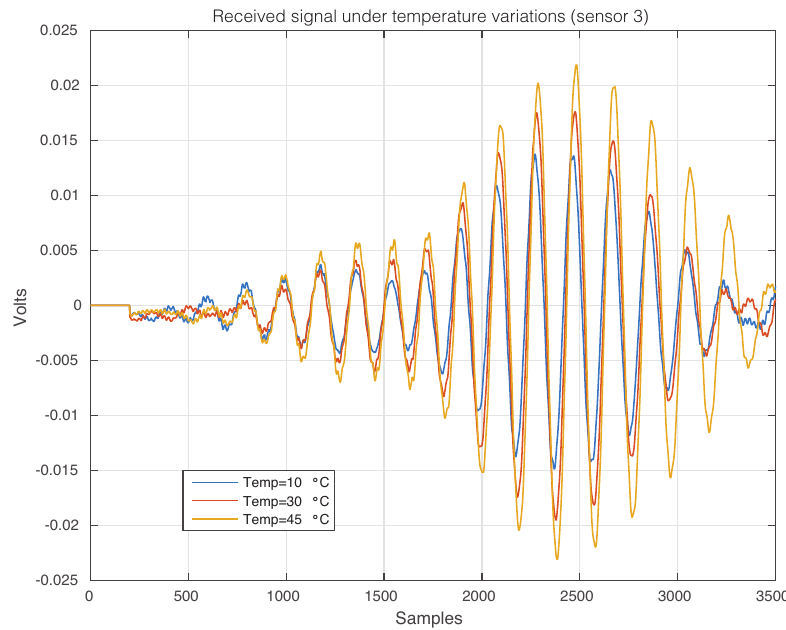
Figure 12. Signal that is received by Sensor 3 when the first sensor is used as an